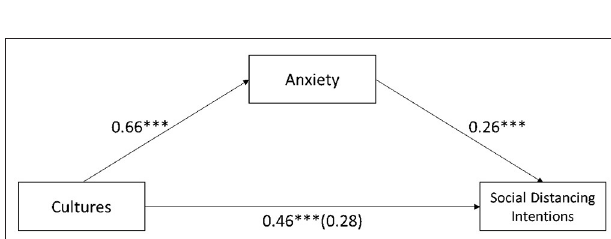
FIGURE 6 | Mediation analysis of anxiety between different cultures and social distancing intentions. ***Significant at 0.01.